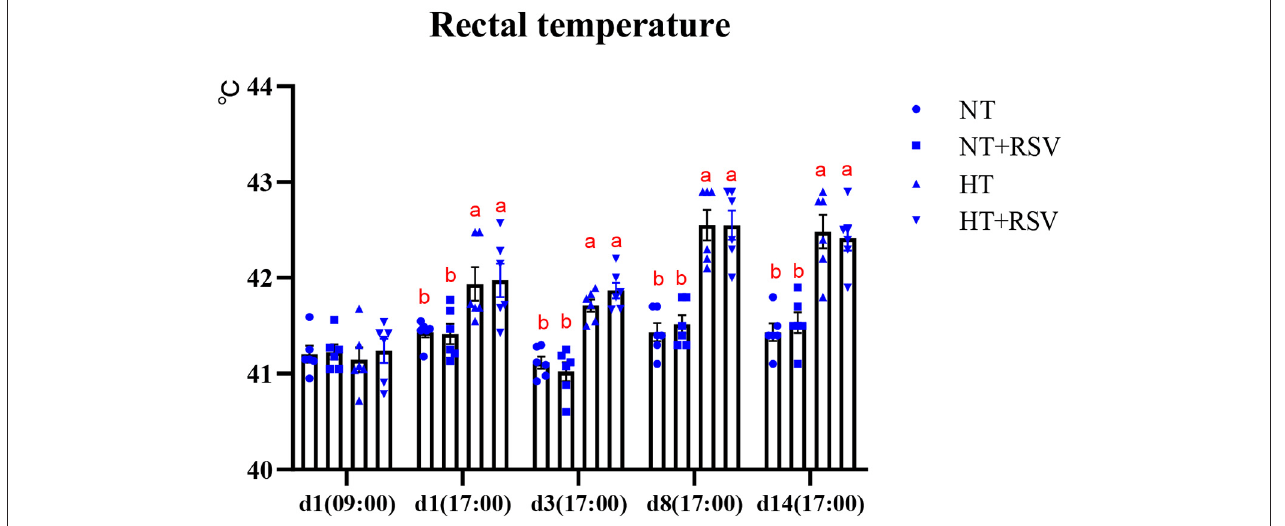
FIGURE 1 | Effect of heat stress and RSV on rectal temperature of 42-day-old broilers (d 14 of heat treatment). Symbols and error bars represent means standard error. Bars represent the means ± SEM ( n = 6), bars with different letters are statistically significant in different treatments. RSV, resveratrol; NT, normal temperature; HT, heat